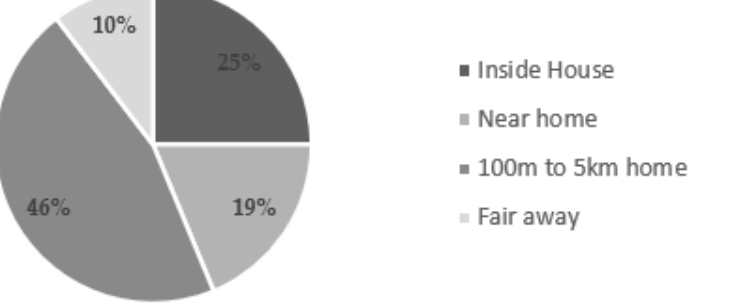
Figure 8. Distance between the residence of the victims and the place of death-October 2017 [17]. About 44% of victims died inside or near houses, but a large percentage of people, about 46%, tried to run away. It should be noted that, according to the ITC report, 60% of the houses of the victims of this fire did not burn. In this case, 63% of the people tried to run away (Figure 9).